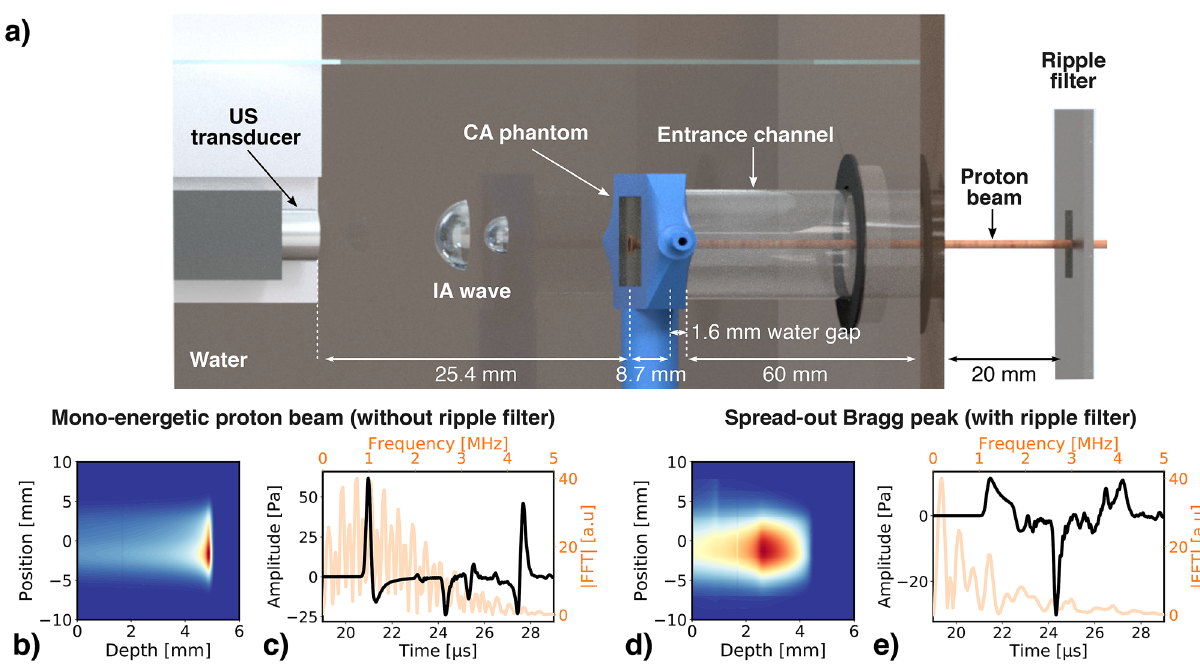
Figure 1. Experimental setup of the ionoacoustic CA study. ( a ) Schematic of the experimental setup in the case of irradiation with the ripple filter. The proton beam enters the water tank through a 50 µ m -thick polyimide foil and stops inside the CA phantom. The ionoacoustic (IA) pressure waves are measured by a CMUT single- element on the proton beam axis. ( b ) Laterally integrated 2D dose map of the 22 MeV proton beam in water, with a range of 4.92 mm (corresponding to 80 % of dose fall-off). ( c ) Simulated ionoacoustic emission resulting from the mono-energetic 22 MeV proton beam for a single proton pulse of 200 ns in water in time (black) and frequency-domain (orange). ( d ) Laterally integrated 2D dose map of the spread-out 22 MeV proton beam in water, with a range of 3.04 mm (corresponding to 90 % of dose fall-off). ( e ) Simulated ionoacoustic emission resulting for the spread-out proton beam from a single proton pulse of 200 ns in water in time (black) and frequency-domain (orange). The dose maps, obtained from Fluka2021.1beta, are the averaged values over 6 randomly sampled pencil